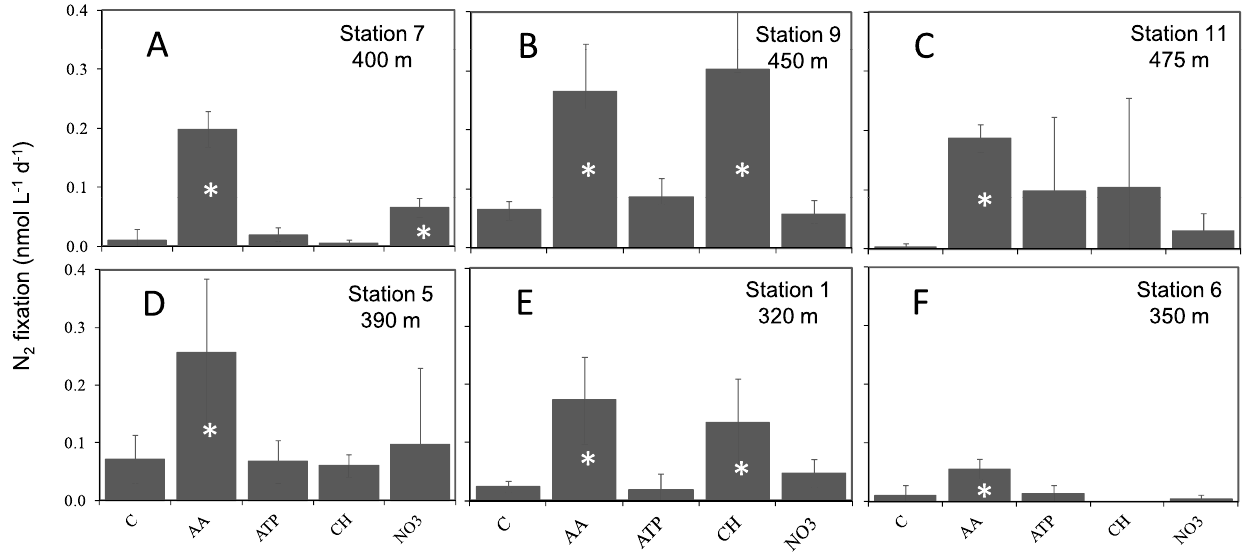
Figure 8. Effects of nutrient additions on mean N 2 fixation rates (n=3) during the Melville cruise (2011) (C: Control, AA: Amino acids, CH: Carbohydrates). Data from bioassay experiments performed in the OMZ at (A) Stations 7, (B) Station 9, (C) Station 11, (D) Station 5, (E) Station 1, and (F) Station 6 during the Melville cruise (2011). The error bars represent the standard deviation of triplicate incubations. Treatment means were compared using the 2-tailed non parametric Mann-Whitney mean comparison test (n=3, a =0.05, unpaired samples). Means that were significantly different (p , 0.05) from the control are labeled with an asterisk.